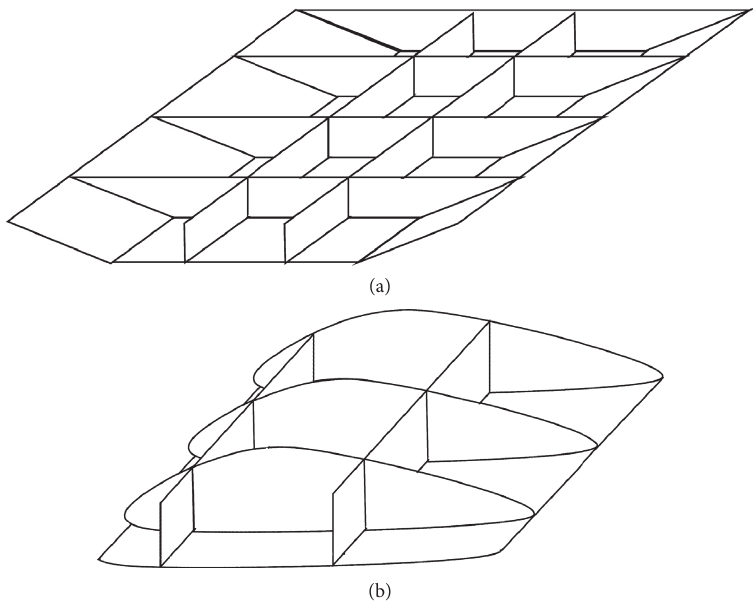
Figure 1: (a) Structure of the steel box girder of the bridge system. (b) Structure of the aircraft